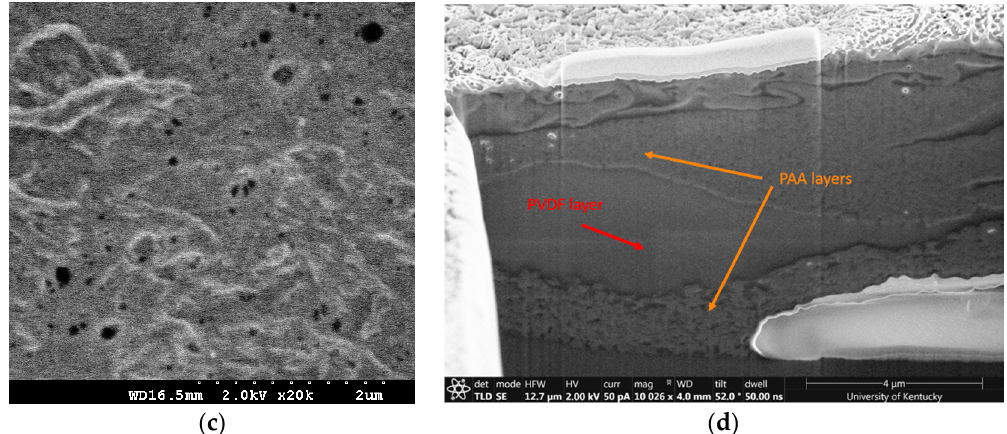
Figure 2. Scanning electron microscopy (SEM) images of ( a ) bare PVDF membrane, ( b ) PAA-functionalized PVDF membrane (PVDF-PAA) and ( c ) enzyme immobilized PVDF membrane (PVDF-PAA-PAH-ENZ) and ( d ) FIB-SEM image of the inside morphology of the pores of the functionalized membrane (PVDF-PAA). The surface compositions of bare PVDF membranes and enzyme-functionalized PVDF membranes (PVDF-PAA-PAH-ENZ) were explored by X-ray photoelectron spectroscopy (XPS). Survey spectra